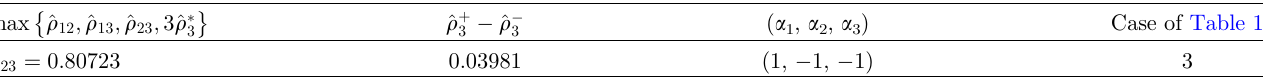
population over 75 years old (code 2) and (iii) per-capita disposable income (code